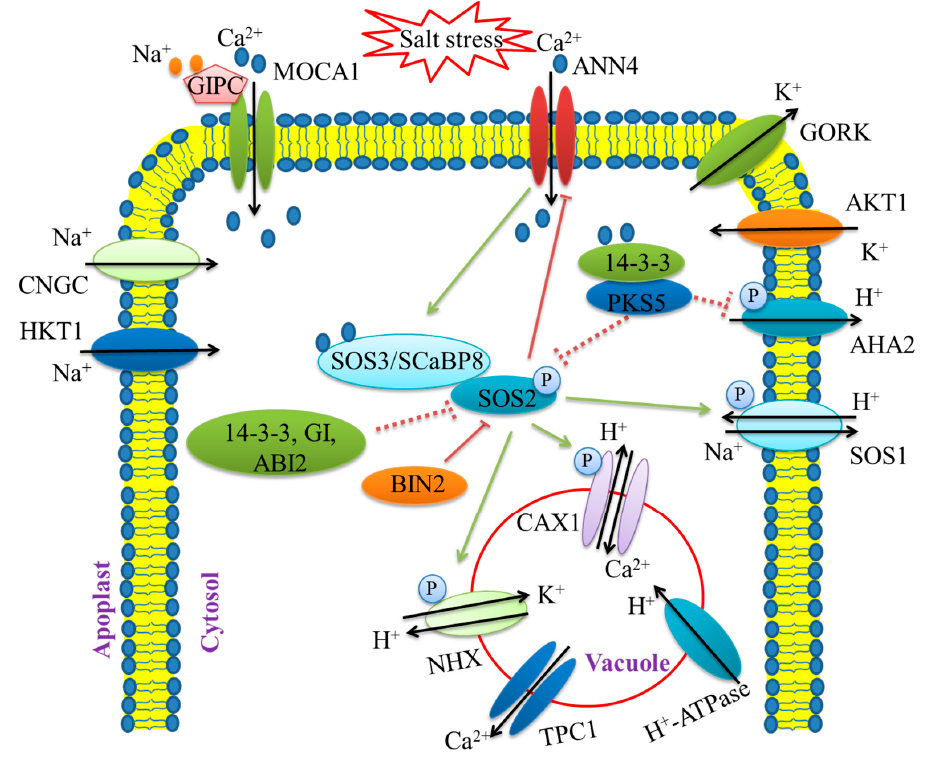
Figure 2. Salt stress triggers ion transport regulation in plant cells. Salt stress induces the accumulation of Na + and Ca 2+ within the cell. The glucuronosyltransferase monocation-induced Ca 2+ increases 1 (MOCA1) is as a Ca 2+ -permeable channel in the plasma membrane. Glycosyl inositol phosphorylceramide (GIPC) sphingolipids sense and bind to Na + to activate the MOCA1-mediated Ca 2+ influx. The cyclic nucleotide-gated ion channel (CNGC) and high-affinity potassium (K + ) transporter (HKT1) are required for Na + transport into the cell. The inward-rectifier K + channel Arabidopsis K + transporter (AKT1) and the outward-rectifier K + channel guard cell outward-rectifier K + channel (GORK) help to maintain the Na + /K + balance. The salt overly sensitive (SOS) pathway plays essential roles in Na + exclusion. The calcium sensor, SOS3/SCaBP8, recruits SOS2 to the plasma membrane and promotes SOS2-mediated phosphorylation of the Na + /H + antiporter SOS1. Under normal conditions, the kinase SOS2 is repressed by 14-3-3, ABA insensitive 2 (ABI2), and GIGANTEA (GI). Additionally, SOS2-like protein kinase 5 (PKS5) phosphorylates and inhibits SOS2. Under salt stress conditions, 14-3-3 and GI are degraded and release SOS2 to phosphorylate SOS1. Then, 14-3-3 represses PKS5, thereby activating SOS2. Under salt stress conditions, the glycogen synthase kinase 3 (GSK3) kinase, brassinosteroid insensitive 2 (BIN2) fine-tunes the SOS2 activity to prevent overactivation. As a putative Ca 2+ -permeable transporter, the ANNEXIN protein member, ANN4, interacts with SCaBP8 and SOS2 and regulates calcium signaling under salt stress. During salt stress, SOS2 activates the vacuolar H + /Ca 2+ antiporter CAX1 to promote Ca 2+ enhancement and regulates the vacuolar K + /H + exchanger NHX to maintain the K + balance. The arrows and bars indicate positive and negative regulation, respectively. Solid lines and dashed lines indicate direct regulation and indirect regulation, respectively.